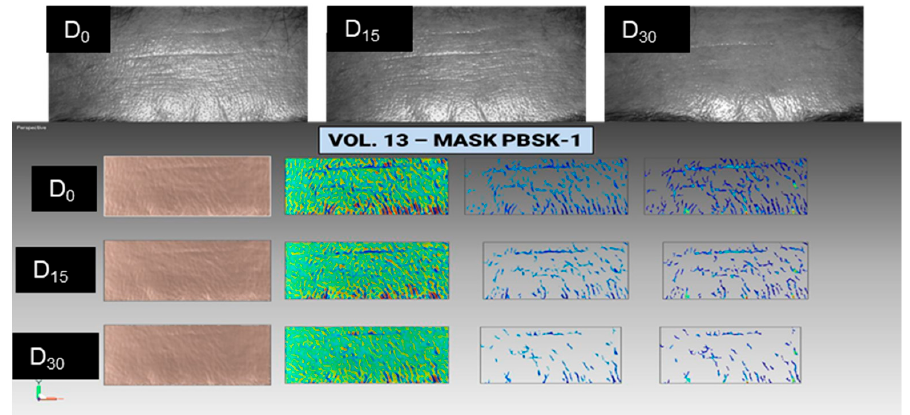
Figure 3. Example of wrinkle study carried out using the image analysis methodology reported